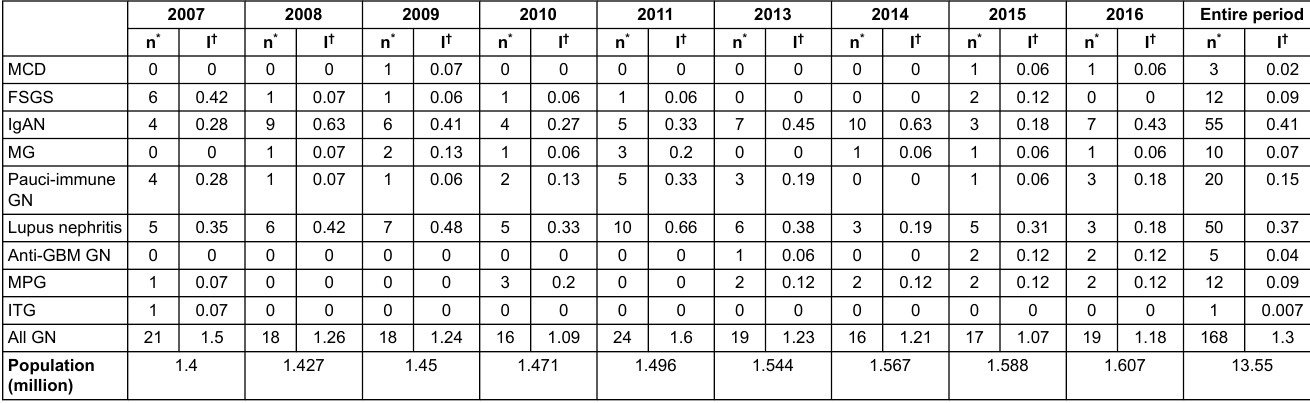
Table 1: Absolute number of patients and incidence of the different forms of primary glomerulonephritis between 2007 and 2016. 2007